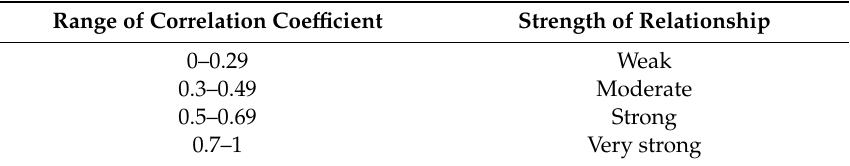
Table 3. Interpretation of the correlation coe ffi